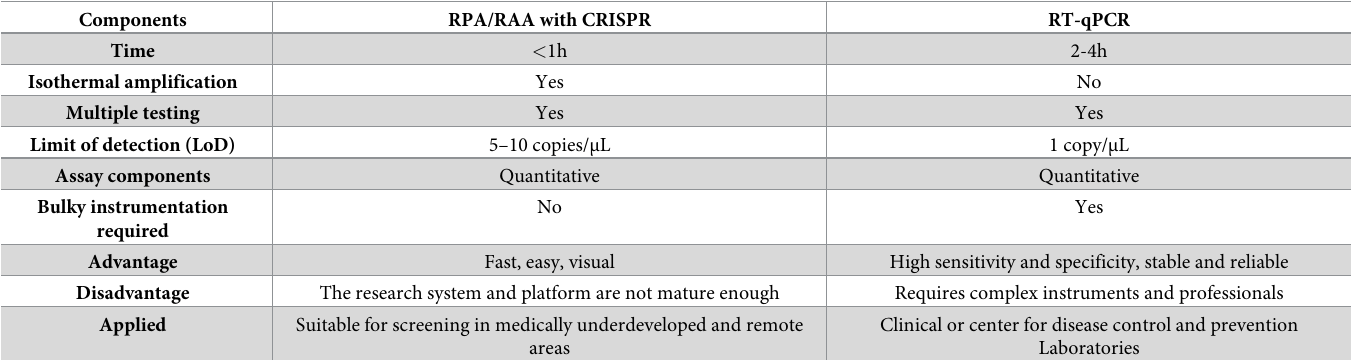
Table 5. RT-qPCR vs CRISPR in